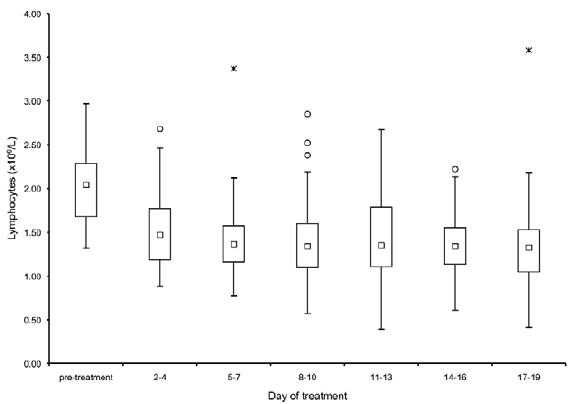
Figure 2. Box-and-whisker plot of the platelet counts of patients plotted against duration of treatment with sodium stibogluconate (SbV). The group median (squares) fell significantly from its baseline by the first subsequent measurement, four days after initiating treatment ( p , 0.001). It then plateaued, with no further significant change. Outliers are depicted by circles, extremes are depicted by hashes.